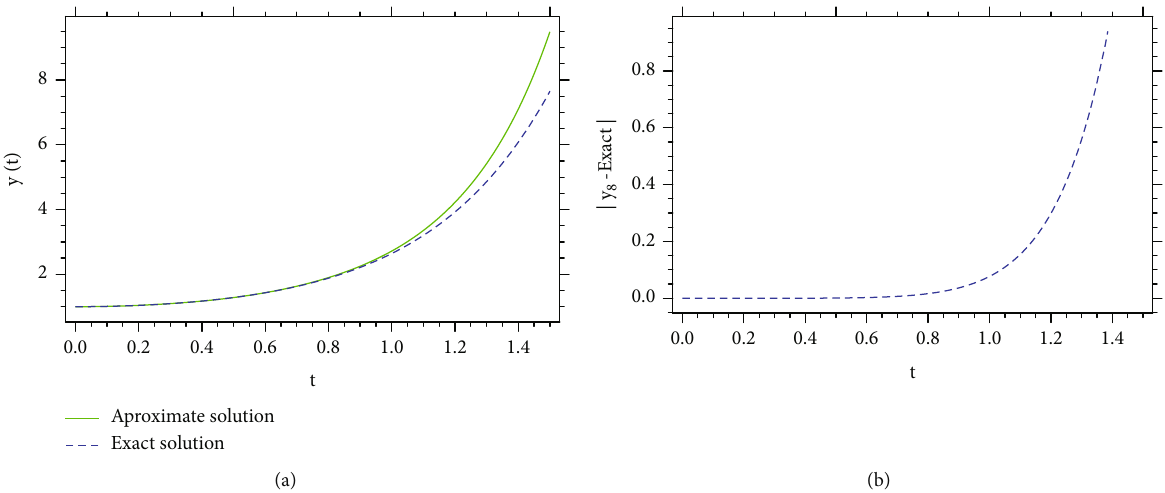
Figure 4: (a) 2D solution plots of Example 4 obtained by the present method in comparison with the exact solutions : (b) The absolute errors of Example 4.